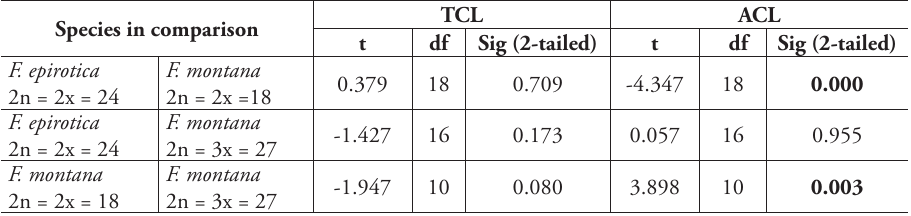
Table 4. Paired t-tests between the three species regarding the TCL and ACL dom (df) and Significance (Sig) for every parameter. Bold characters are used for P values (Sig 2-tailed) under 0.01, which reveal significant statistical